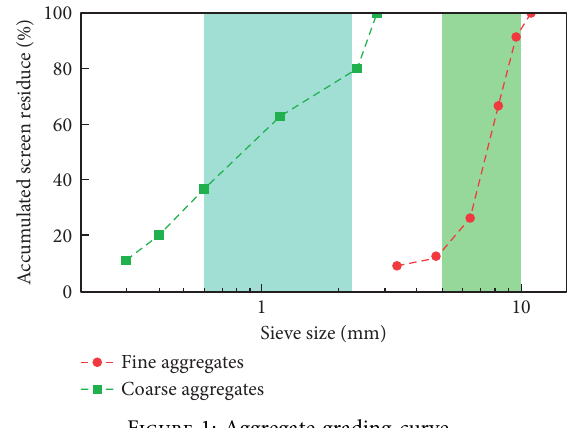
Figure 1: Aggregate grading